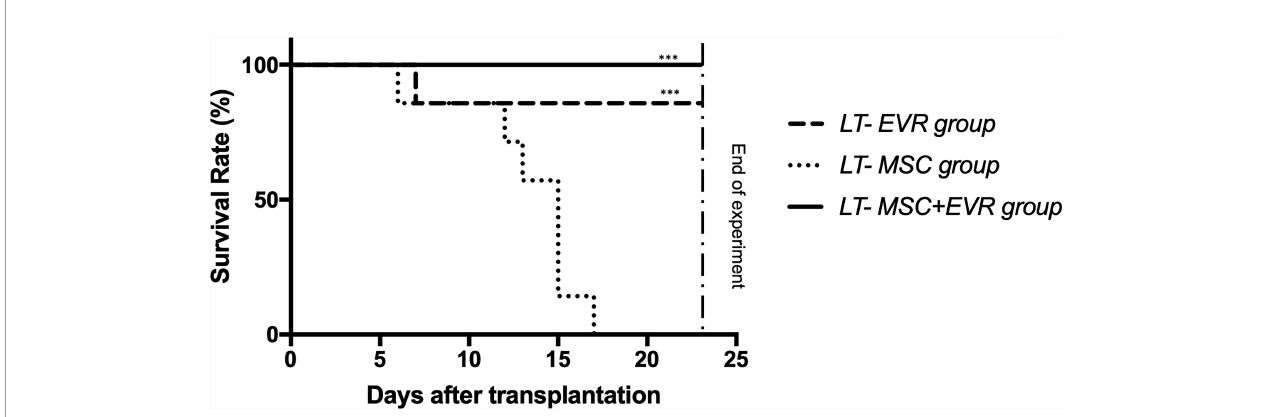
FIGURE 5 | The Kaplan-Meier survival curve of liver transplant recipients. Kaplan-Meier survival curves for the LT-EVR, LT-MSC and LT-MSC+EVR groups. The survival rates for the LT-EVR and LT-MSC+EVR groups were signi fi cantly higher than those of the LT-MSC group . All rats of the LT-MSC group died between post- operative day 6 and 17; Graft survival was analyzed with the Kaplan-Meier method using the log-rank (Mantel-Cox) test. (***P < 0.001; LT, liver transplanted rat; EVR, Everolimus; MSC, mesenchymal stromal cells).